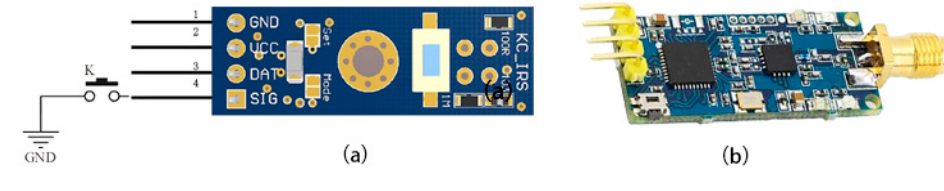
Figure 3. ( a ) KC_IRS, ( b ) DL-22.